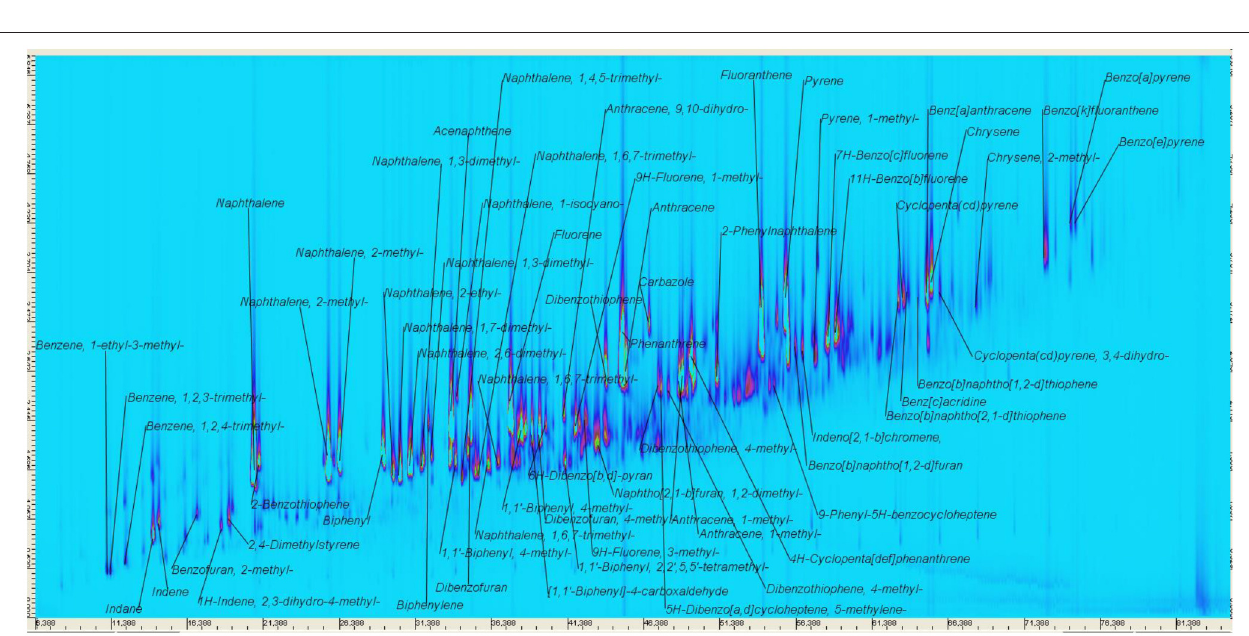
FIGURE 2 | GCxGC-MS Chromatogram of the coal tar DNAPL. Some compounds are identified based on their spectral library match (match factor at least 850), some isomers were not unambiguously identified. Modified from Scherr et al. (2016), reused with permission from